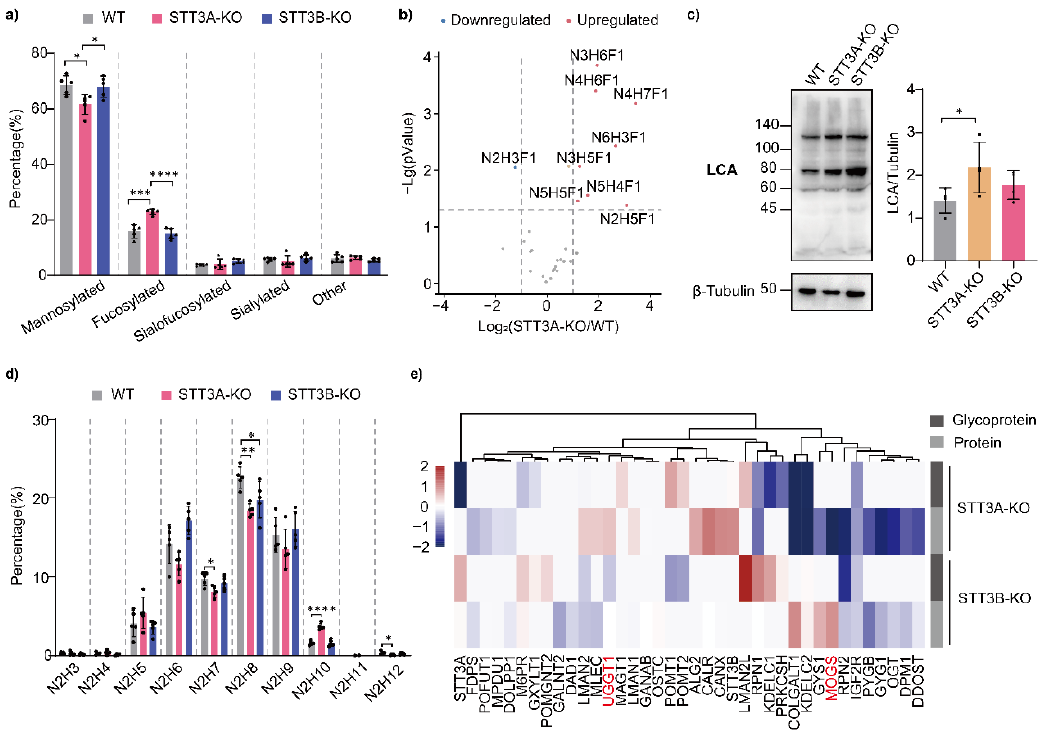
Figure 4. Relative abundance of N-glycan profiles and N-glycan-related proteins in STT3A-KO and STT3B-KO compared to WT HEK293 cells. ( a ) Percentage of different N-glycans. Mannosylated: paucimannose, oligomannose-type and Glc (1–3) Man9GlcNAc2 N-glycans; fucosylated: N-glycans modified by fucose, but not sialic acid; sialofucosylated: N-glycans modified by both fucose and sialic acid; sialylated: N-glycans modified by sialic acid, but not fucose; other: hybrid and complex type glycans with no fucose or sialic acid modification. ( b ) Volcano plot of fucosylated glycans in STT3A-KO cells. N: N-acetylhexosamine; H: hexose, F: fucose. ( c ) Lectin blotting using LCA and the quantitation in WT and KO cells. LCA: Lens culinaris agglutinin. ****, p -value < 0.0001; ***, p -value < 0.001; **, p -value < 0.01; *, p -value < 0.05. ( d ) Relative abundance of all identified mannosylated N-glycans. ( e ) Expression of N-glycan-related proteins detected in proteins and glycoproteins. The color indicates log 2 values of relative abundance changes in KO cells compared to WT cells. Red indicates upregulated, while blue indicates downregulated. Scales were limited from − 2 to 2.